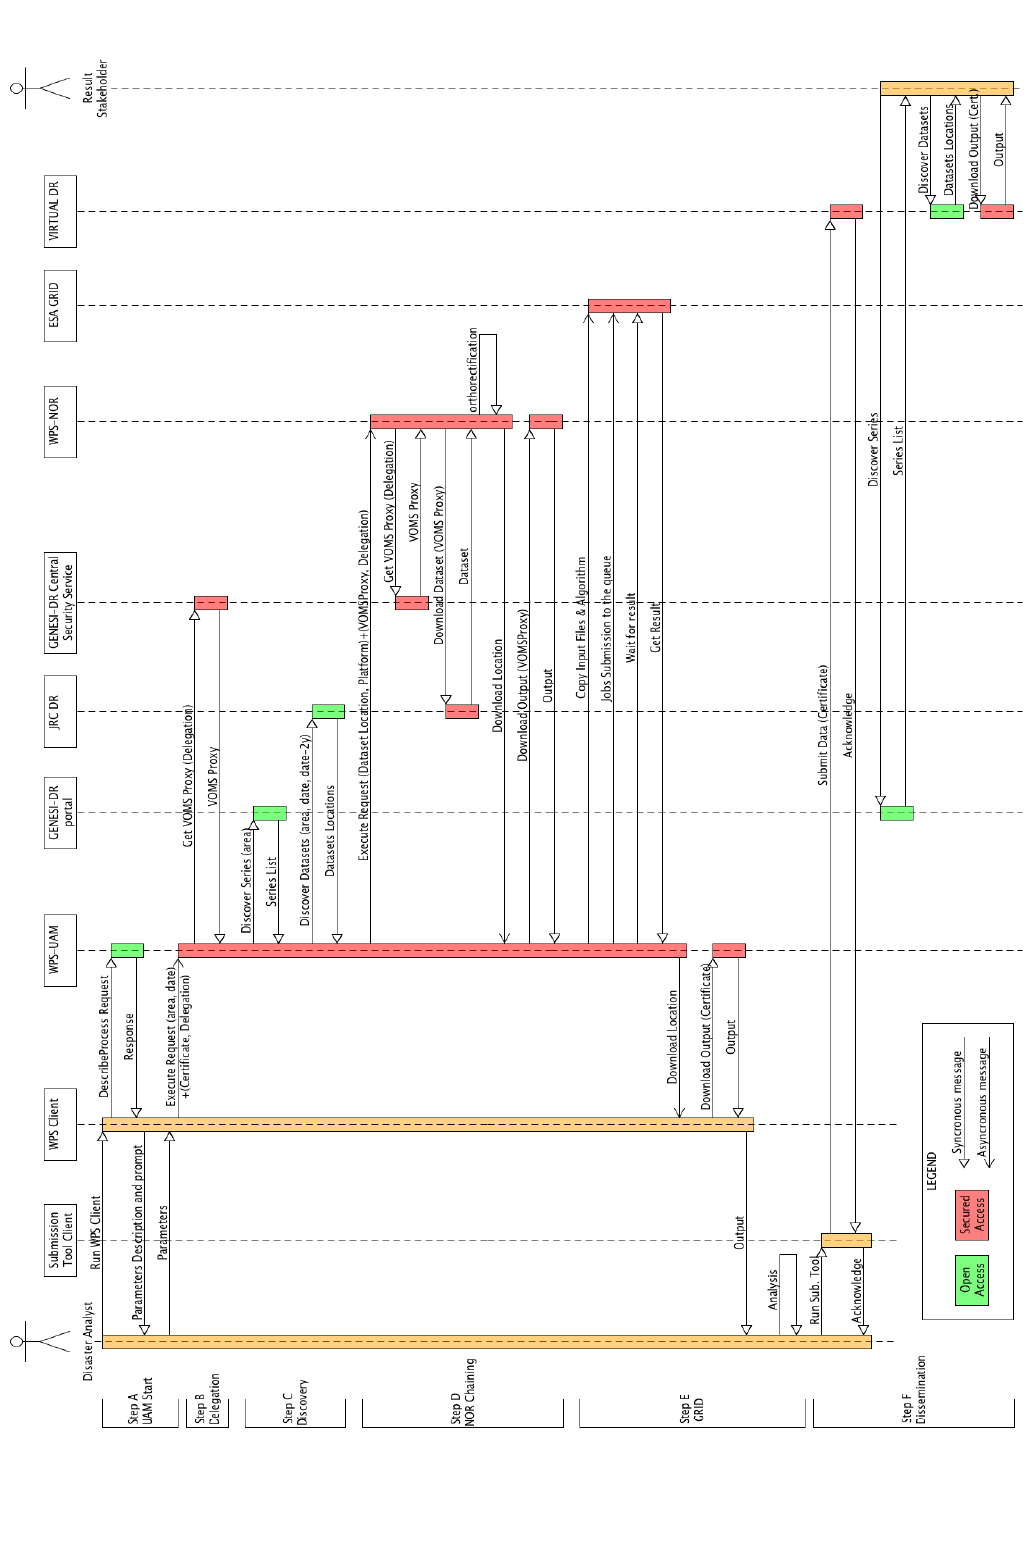
Figure 2. Sequence Diagram of the GENESI-DR technology demonstration for the described post-disaster damage needs assessment scenario using WPS. The media file that accompanies this article provides additional